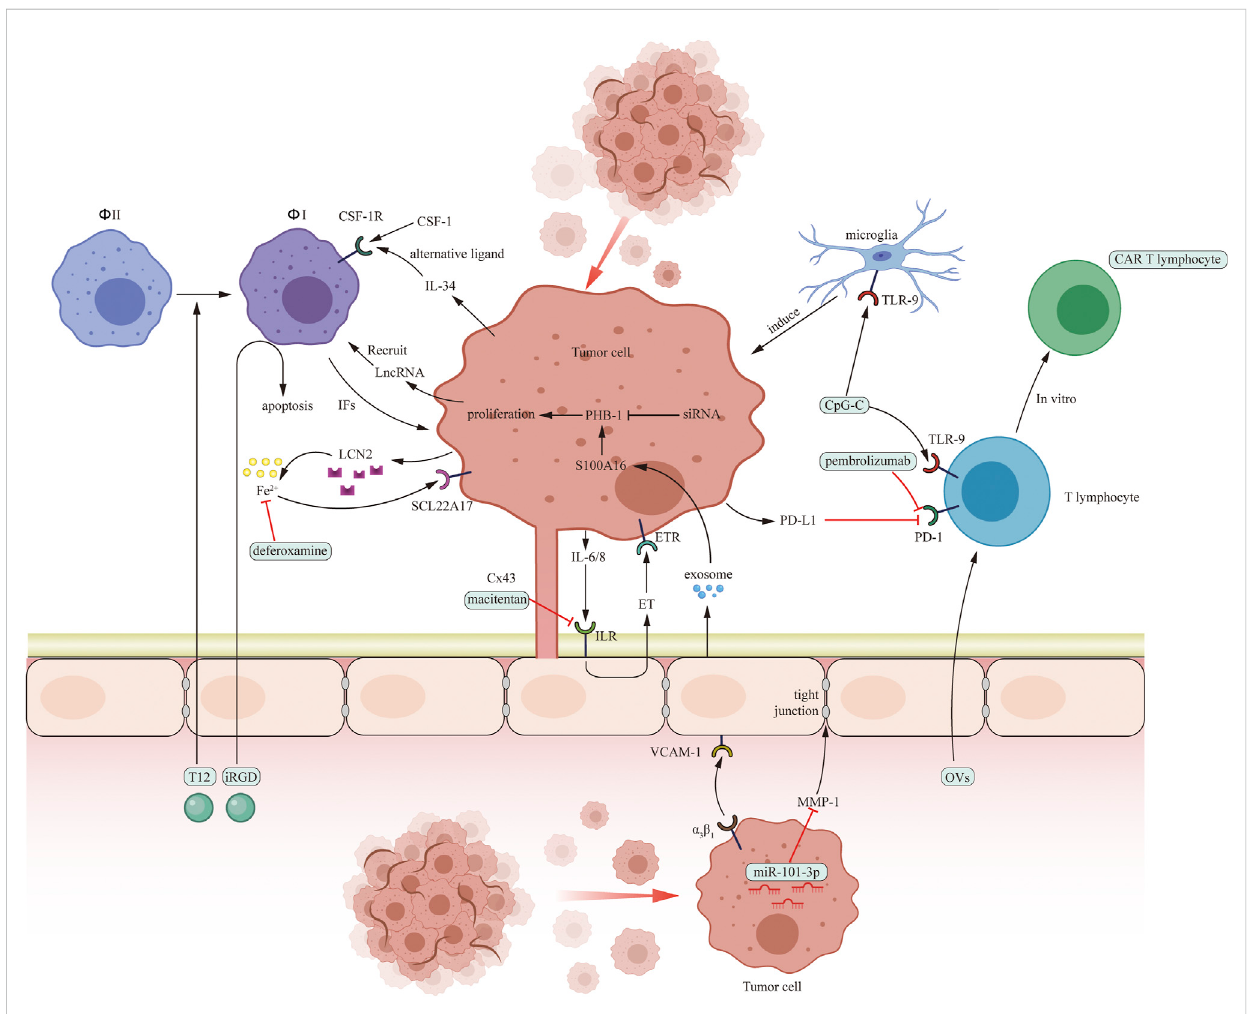
FIGURE 2 Pro-tumoral interaction between cancer cells and several cells in brain microenvironment including macrophages ( Φ ), microglia, T cells and endothelial cells and potential drug targets in brain microenvironment. The green boxes contain drugs used in experiments targeting microenvironment in vitro or in vivo